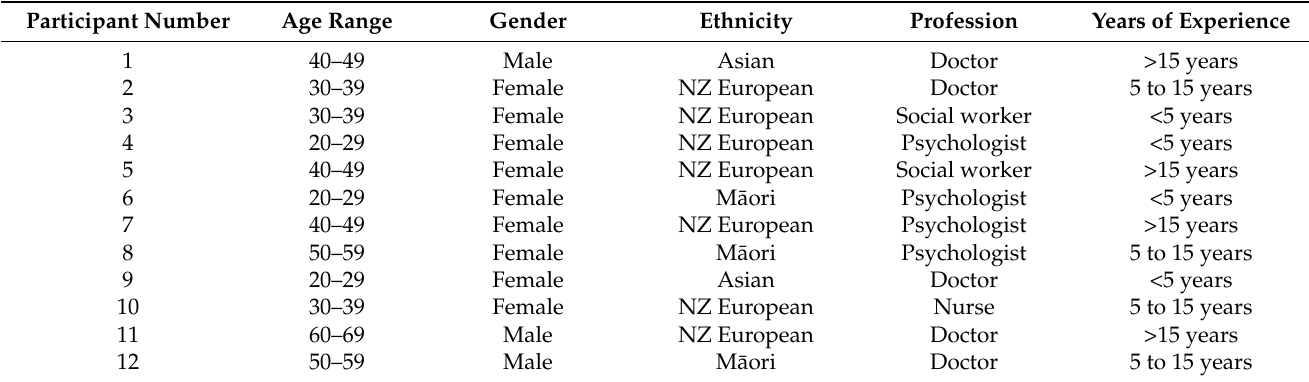
Table 1. Participants’